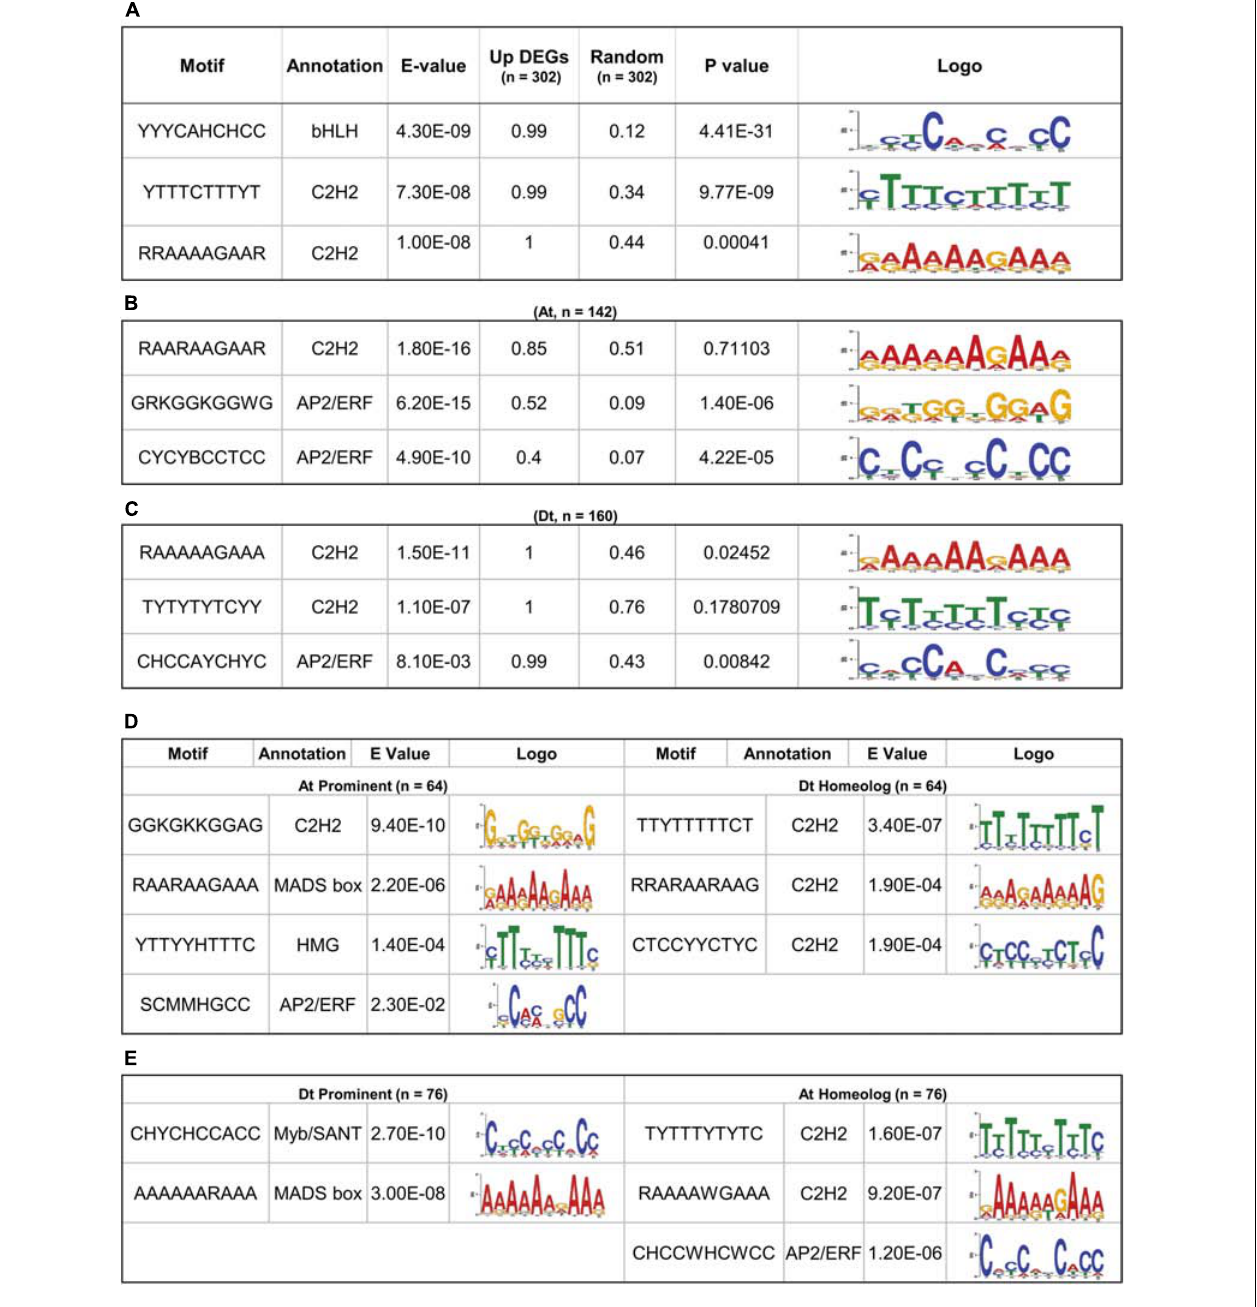
FIGURE 2 | Significant motif enrichment analysis of upregulated DEGs with the random datasets and their homeolog. (A) The three enrichment motifs of 302 upregulated DEGs with the E-value < 0.05 and their significant frequency of occurrences ( P < 0.05) with a similar number of random datasets. (B) Significantly enriched motif of 142 At-containing DEGs and (C) 160 Dt-containing DEGs with the random datasets. (D) Motif enrichment of 64 out 142, At prominent DEGs with their respective Dt homoeologous genes and (E) motif enrichment of 76 out of 160 Dt prominent DEGs with their respective At homoeologous